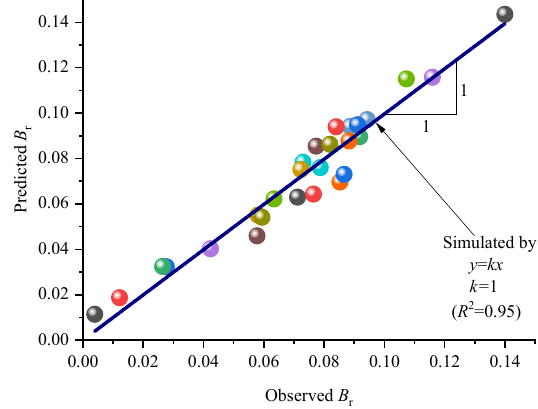
Figure 8. Comparison between observes B r and predicted B r .